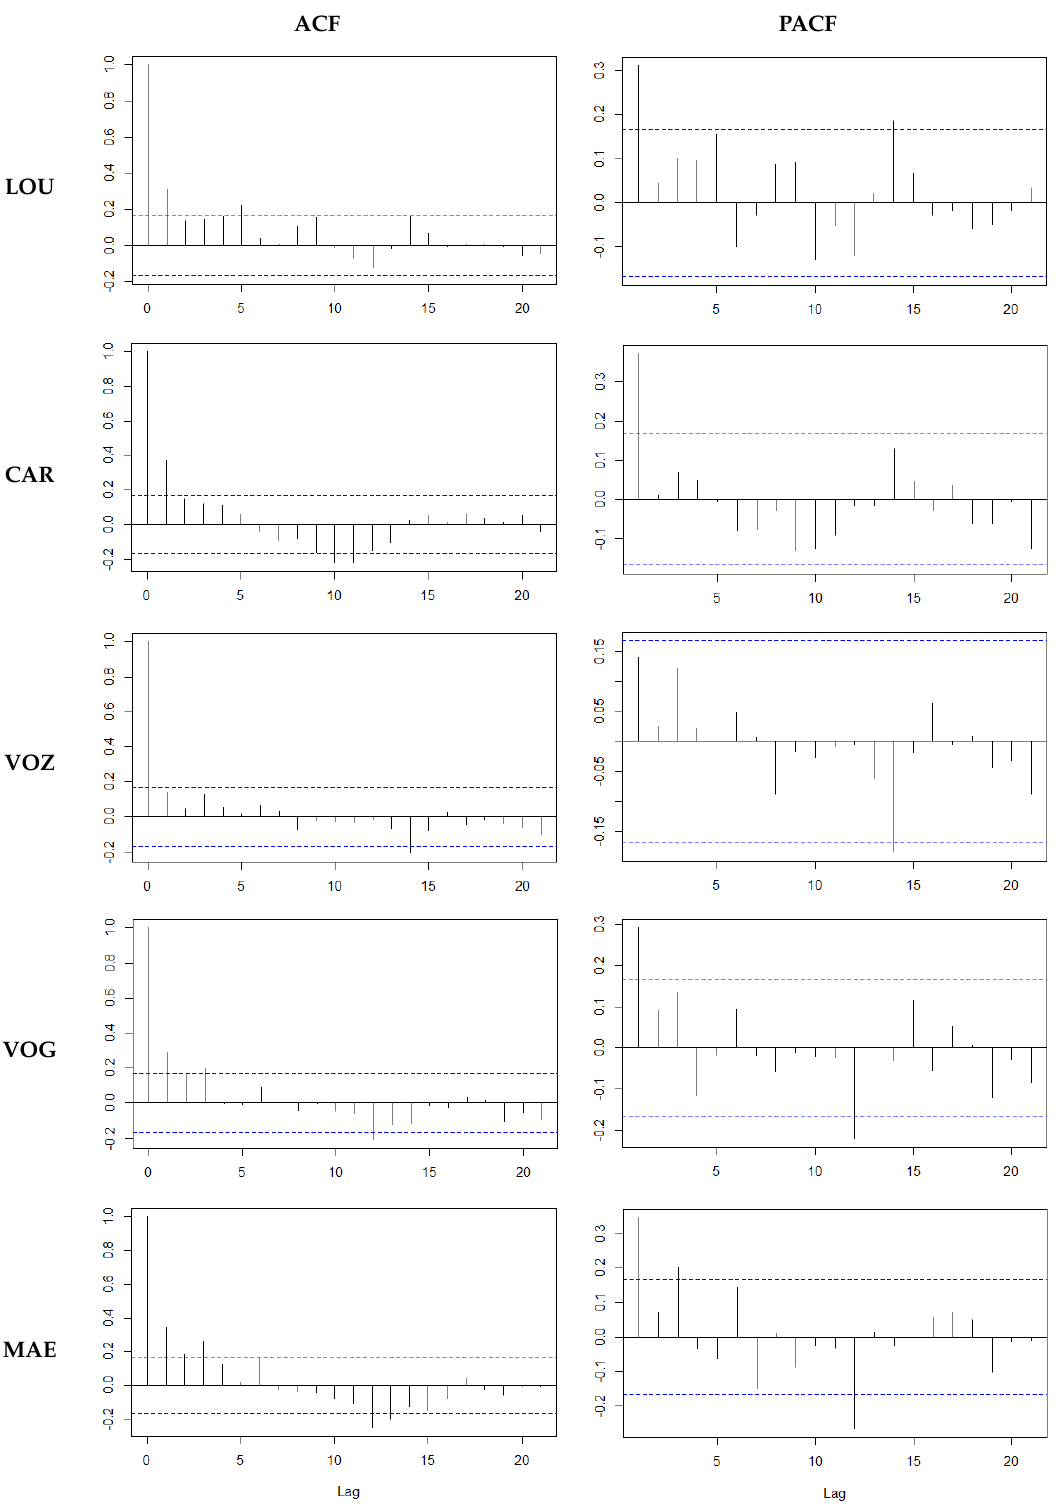
Figure 2. Sample autocorrelation function (ACF) and partial ACF (PACF) for the residuals of the base model (model MI (1)) at the different locations with several